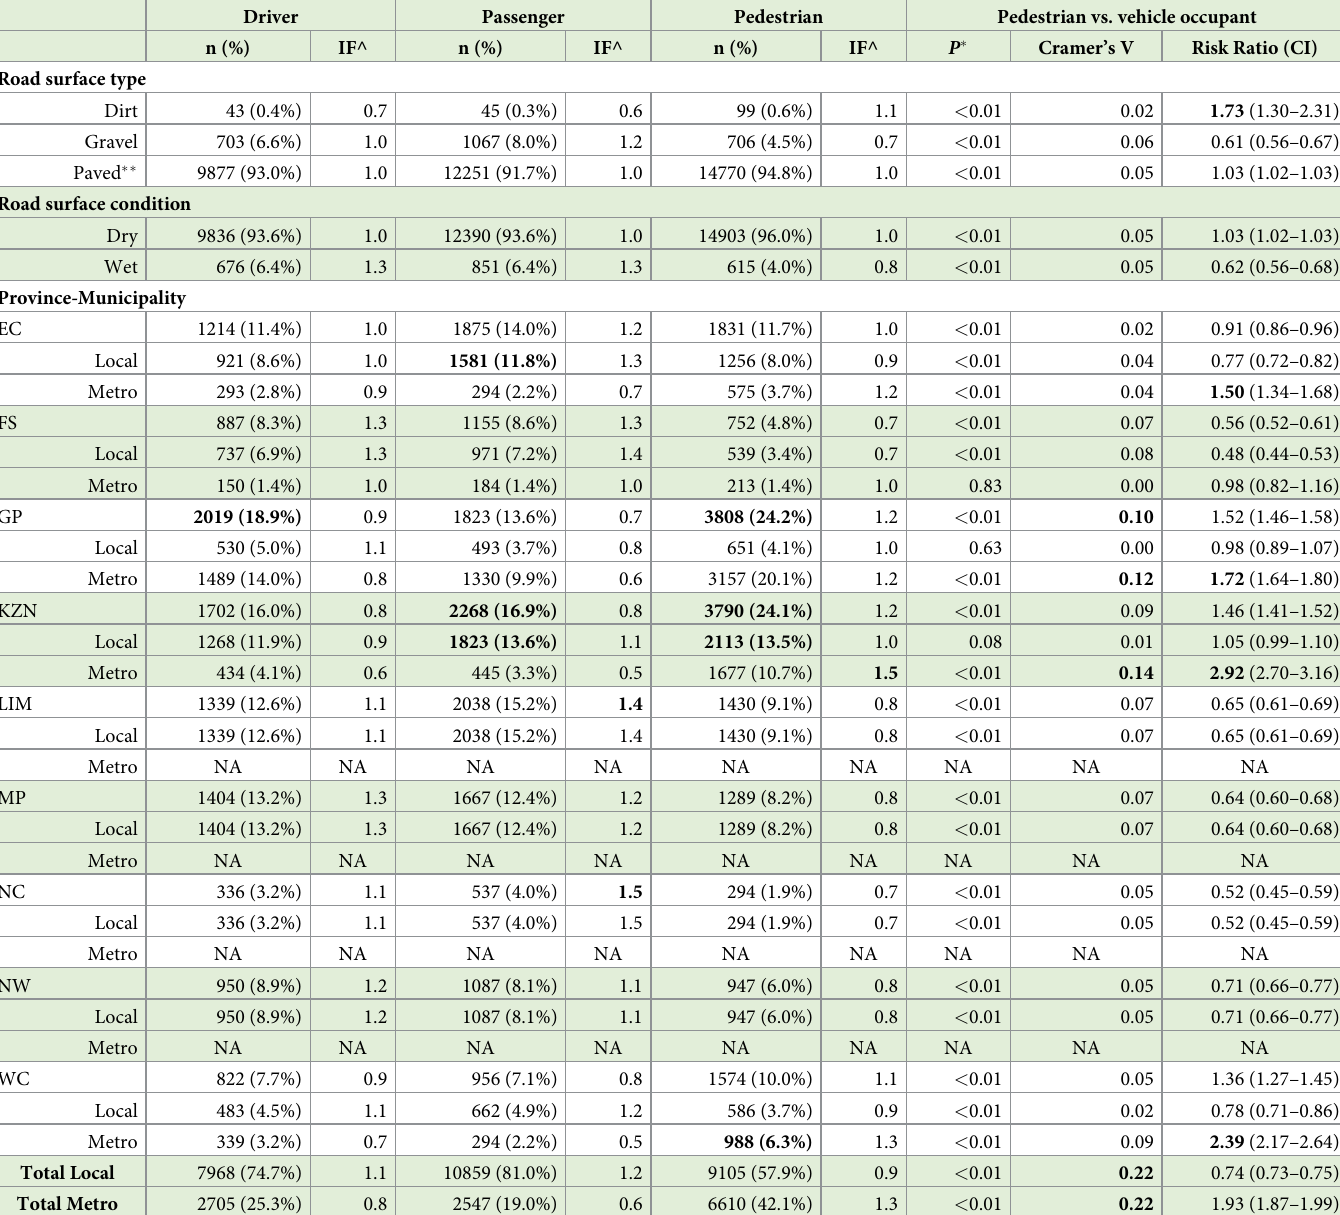
Table 2. Area-level risk factors for fatal crashes by road user mode of